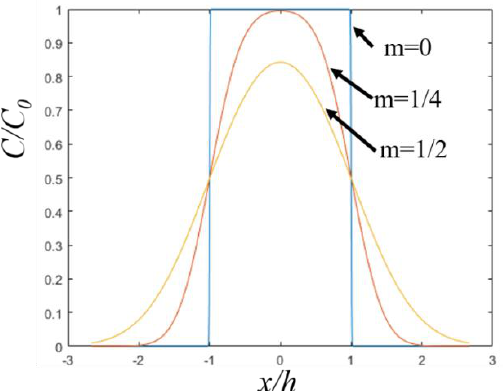
Figure 15. Schematic showing the shape analysis of manganese profiles. C and C 0 represent the manganese concentrations in the WEL and pearlite cementite, respectively; x / h is the ratio of the manganese diffusion distance to the original cementite width; m represents the ratio of the diffusion length to the zone width (additional details are provided in the main text).